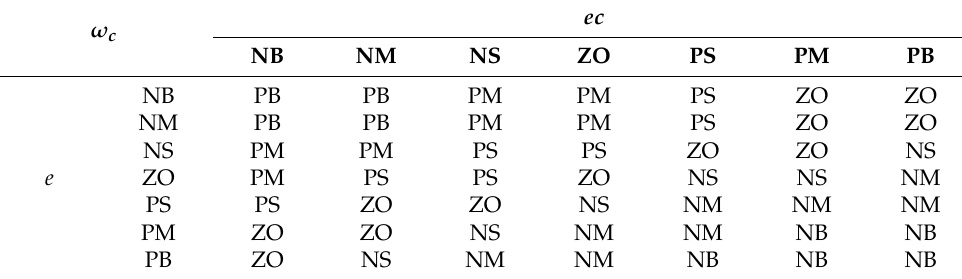
Table 4. Fuzzy rules for ω c .